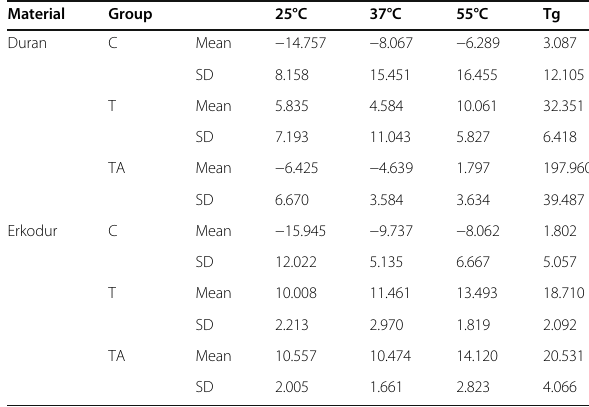
Table 6 Descriptive analysis of E ″ at different temperatures Material